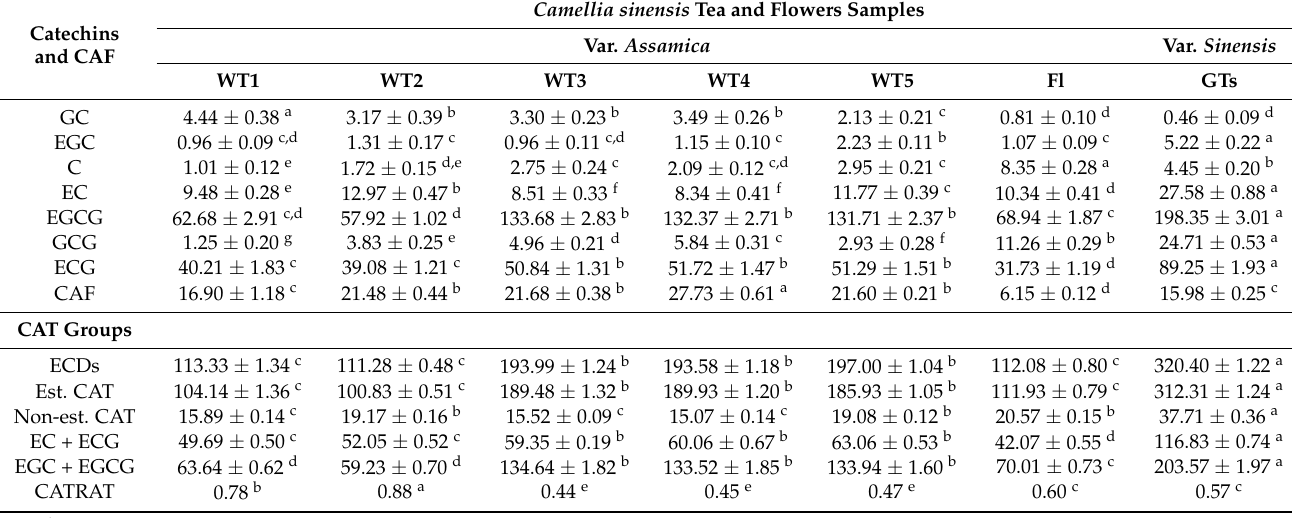
1 Values are mean ± SD ( n = 3). The values presented for GTs are the average of five samples processed under the same conditions. Different superscript letters are significantly different ( p < 0.05). GC—gallocatechin; EGC—epigallocatechin; C—catechin;